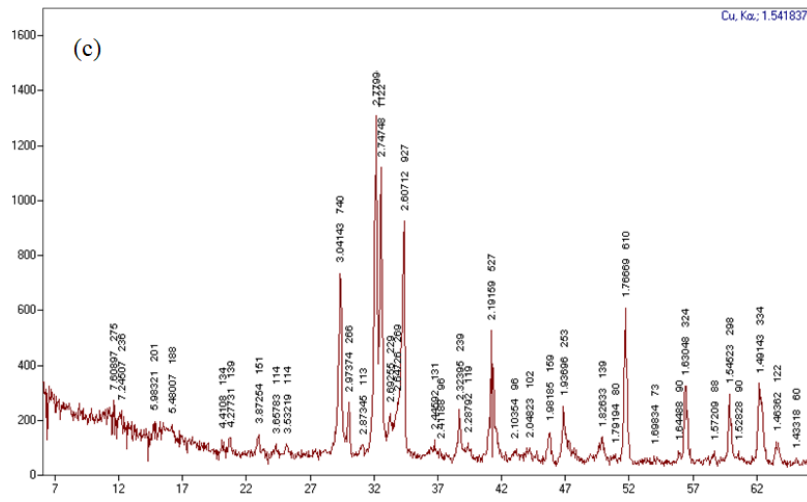
Figure 3. Cement characteristics: ( a ) isothermal calorimetry, ( b ) total heat evolution curves, and ( c ) cement diffraction pattern.